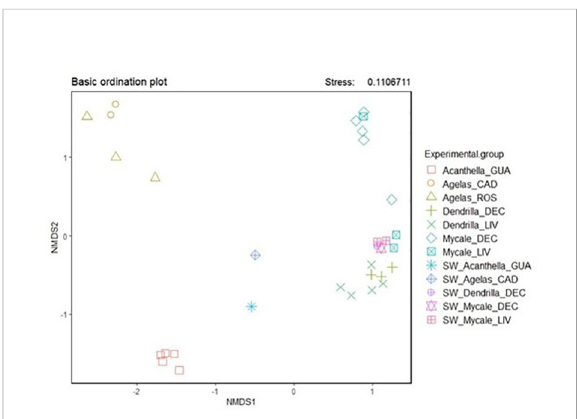
FIGURE 4 Non-linear multidimensional scaling representation of the different sponge species from the different geographic areas and sampling locations and their surrounding water. DEC, Deception Island; LIV, Livingston Island; GUA, Guam; ROS, Roses; CAD, Cadaque ́ s; SW, seawater.